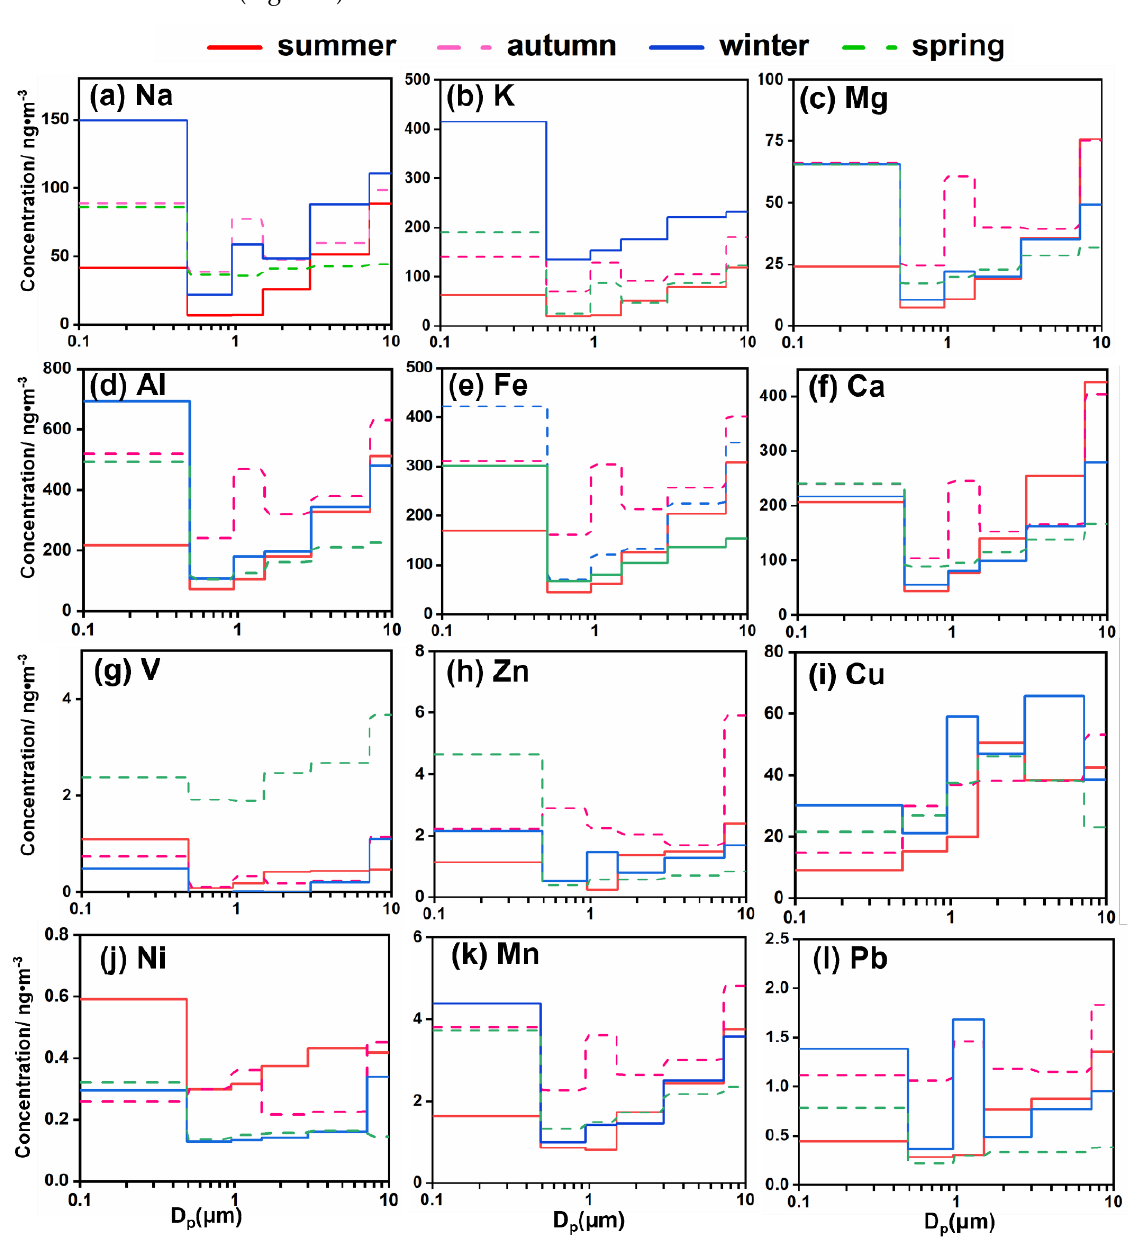
Figure 8. Concentration size distribution of trace elements during different seasons ( a – l ). The element Fe included both anthropogenic sources, such as mining dust and con- struction building, and natural sources, such as barely Fe-rich soil [64]. It was observed that the mass distribution concentration of Fe presented two peaks, at< 0.49 µ m and >7.2 µ m. However, the changes during the seasons were slightly different. Apart from the effects of anthropogenic sources, climatic conditions such as low relative humidity and no rainfall (except summer) were beneficial for resuspended dust and soils